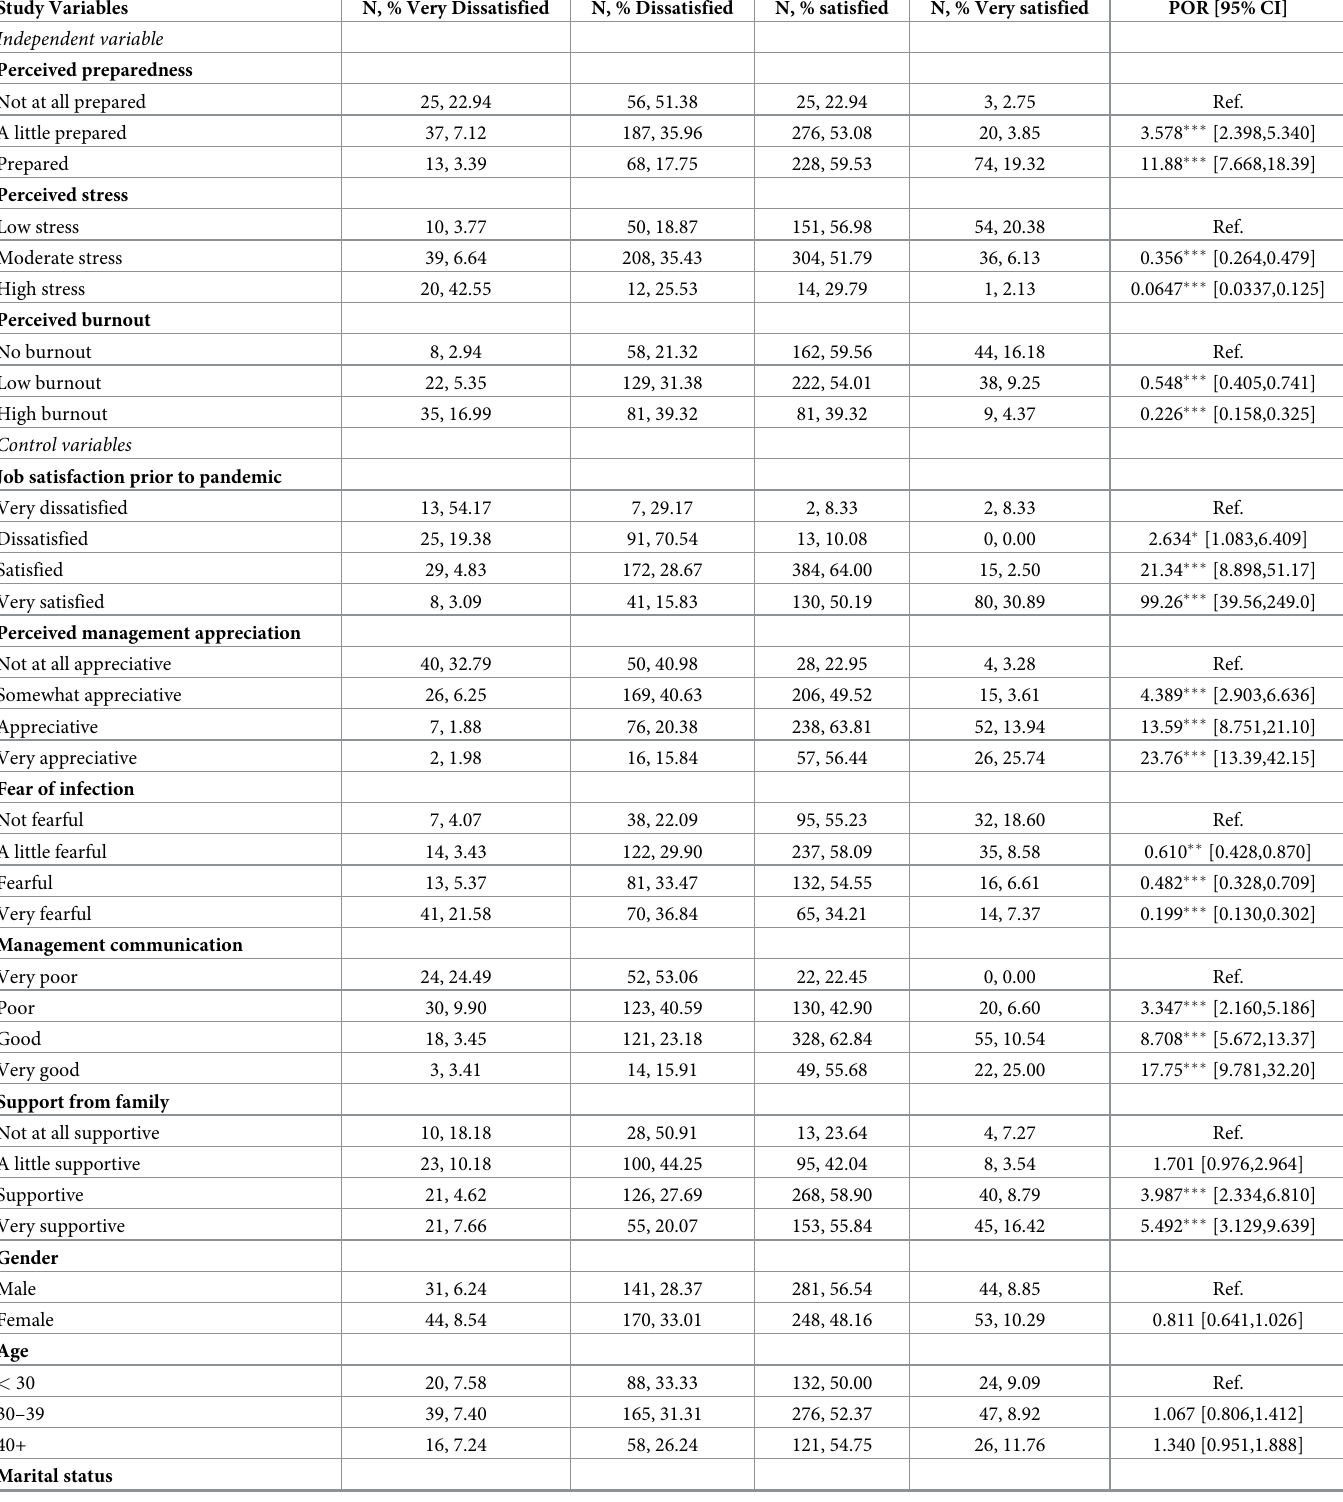
Table 2. Bivariable association between key independent and control variables and current job satisfaction. Study